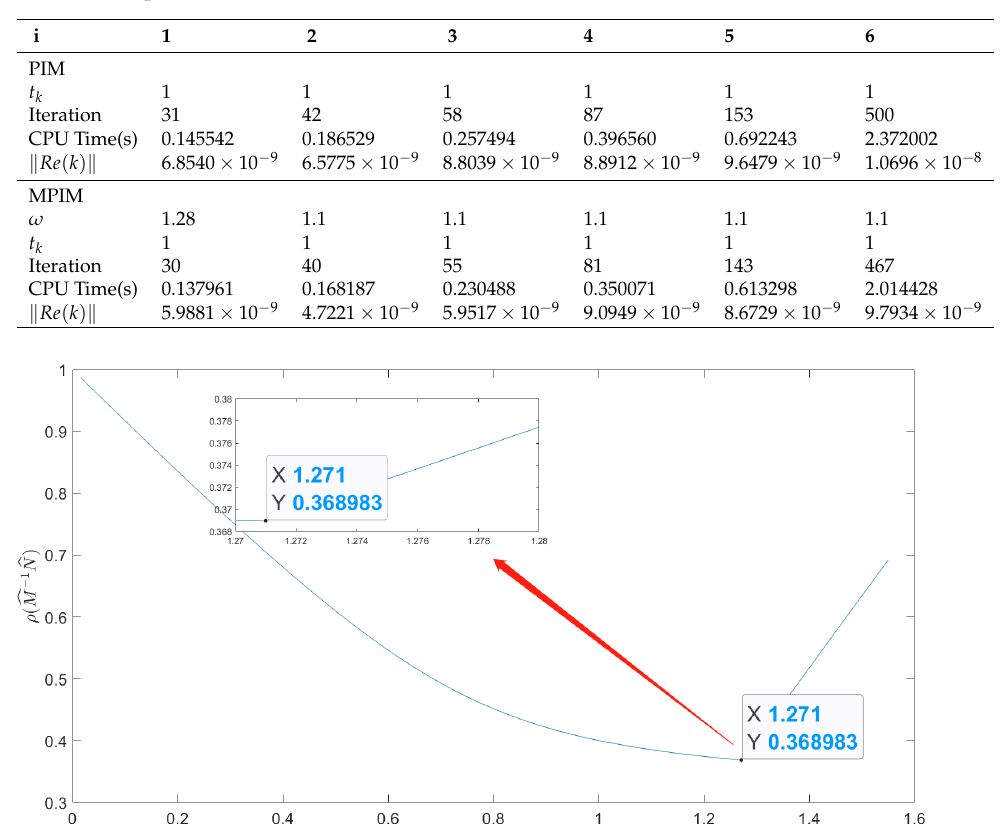
Table 3. Comparision of the iteration number and the CPU time for M i , i = 5,6.